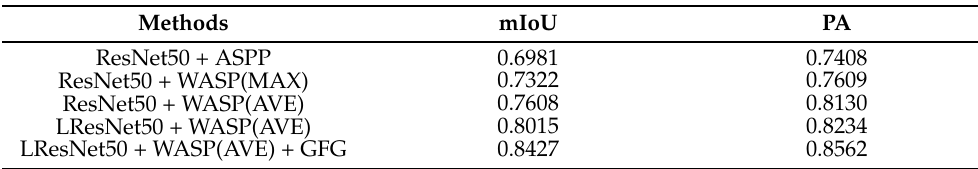
Table 6. Comparison experiments of the Semantic Segmentation module with different settings, using the Satellite dataset II (East